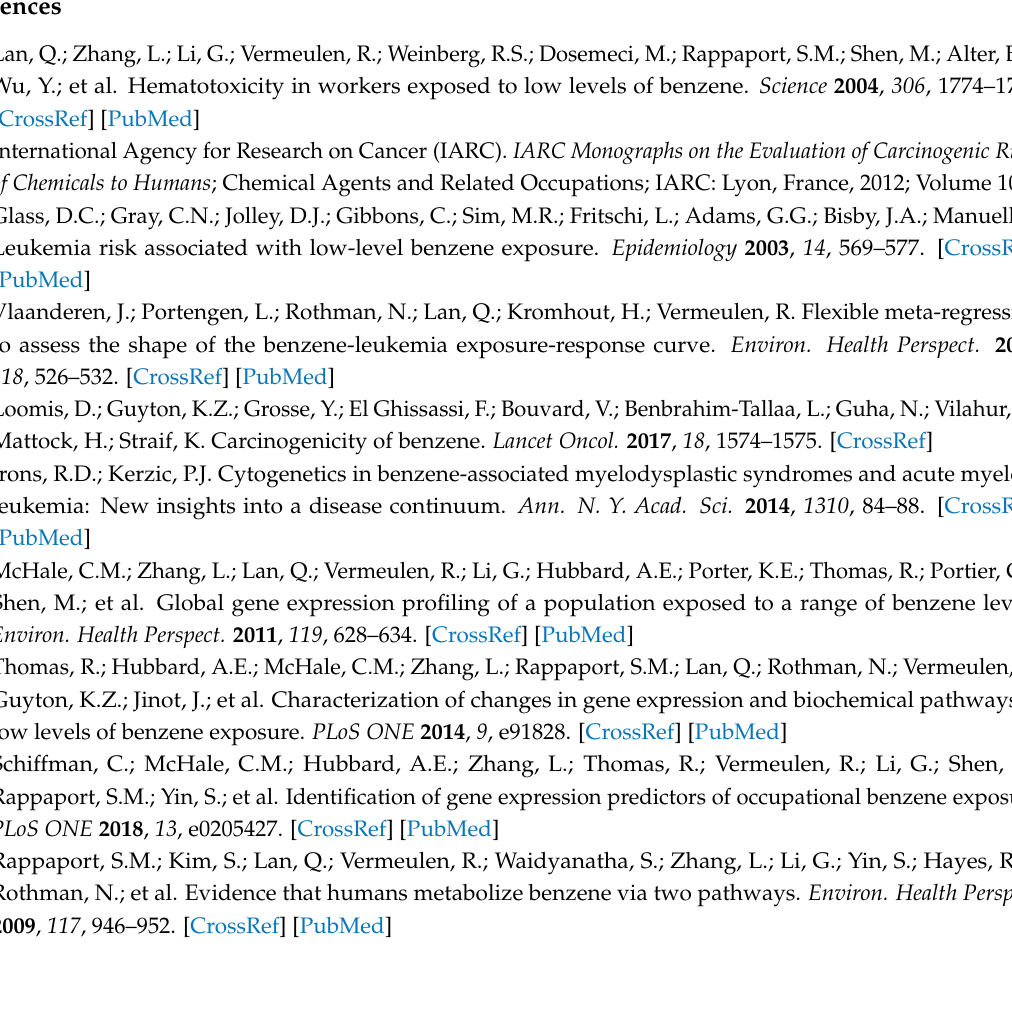
Time series plots of average gene expression without fold change of 20 selected marker genes in referents vs. exposed workers. Figure S11. Confidence intervals of the difference in average gene expression between referent and exposed workers of 20 selected marker genes in data without fold change (page 1) and with fold change (page 2). Other files: running scripts for R for all models and